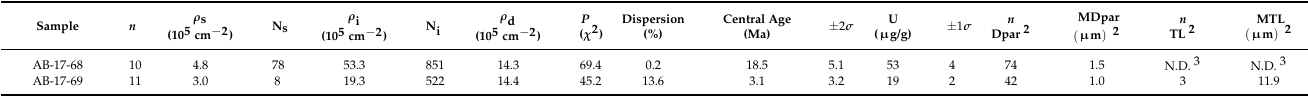
Table 3. Revised apatite fission-track data for the Machu Picchu profile 1